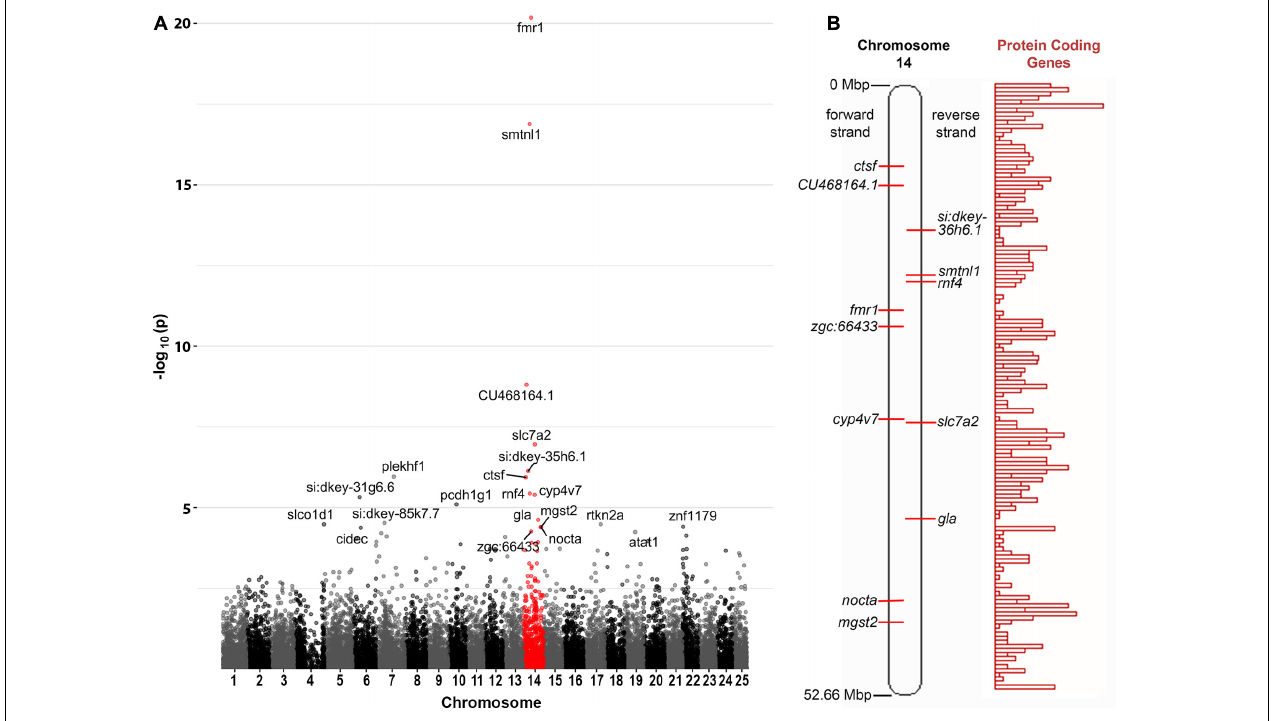
FIGURE 2 | Chromosome distribution of DE genes. (A) Manhattan plot of p -values for differential expression of genes on the chromosomes of zebrafish. An enrichment for DE genes on Chromosome 14 is apparent with possible enrichment also for genes on Chromosome 22 (see also Supplementary Data File 2 ). (B) A diagram of zebrafish Chromosome 14 taken from https://asia.ensembl.org (Yates et al., 2020) and including a representation of relative protein coding gene density along the chromosome. Loci for the Chromosome 14 genes found to be DE in fmr1 hu 2787 / hu 2787 2 dpf embryos are indicated (see also Table 1 ). TABLE 2 | PCR primer pairs used to quantify relative genomic DNA copy number. Gene Chromosomal location (ENSEMBL) PCR primer sequences Mean ratio gene/ rpl13